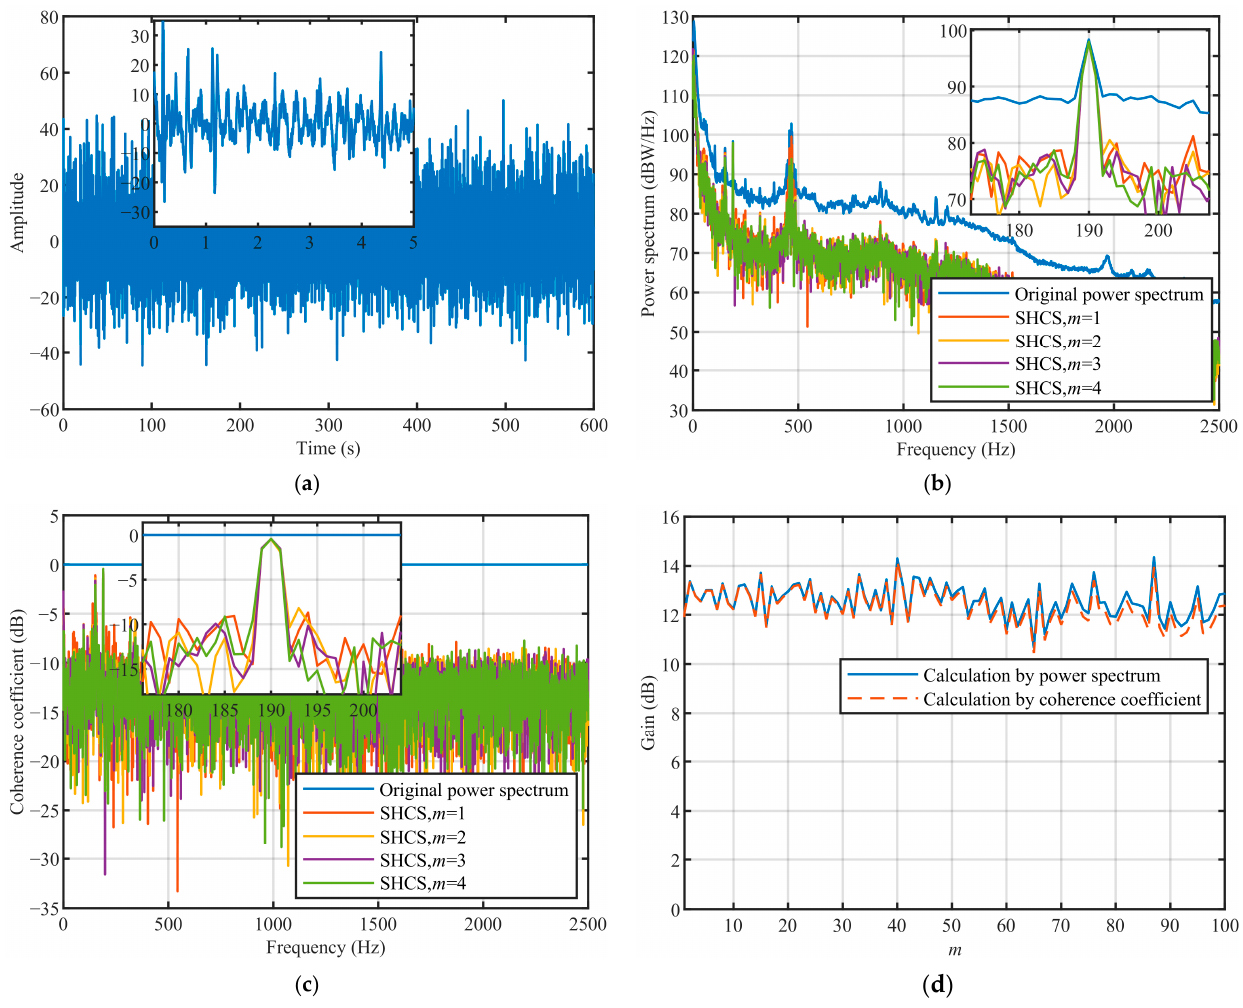
Figure 9. SHCS processing results at 50 km with different values of m : ( a ) time domain waveform; ( b ) power ‐ spectrum estimation; ( c ) coherence coefficient; ( d ) gain.